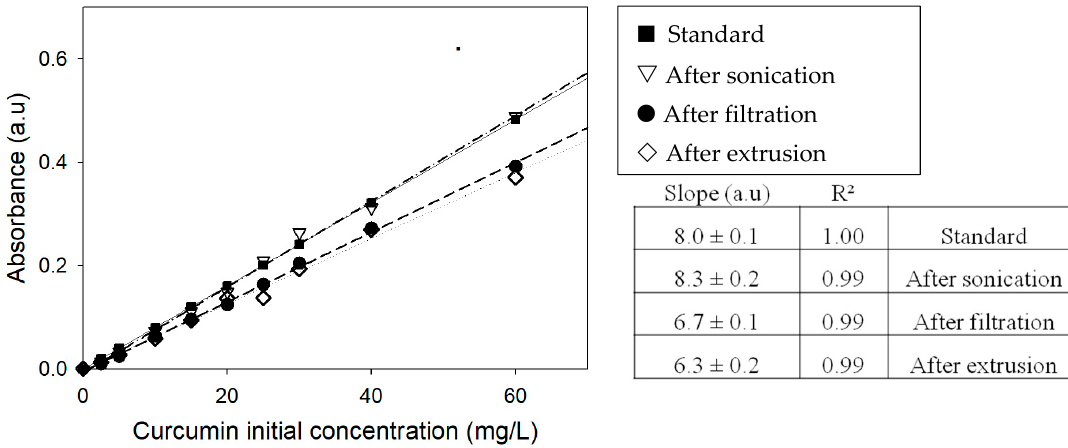
Figure 2. The absorbance of curcumin at 425 nm after various steps of the elaboration process for the different initial added amounts.